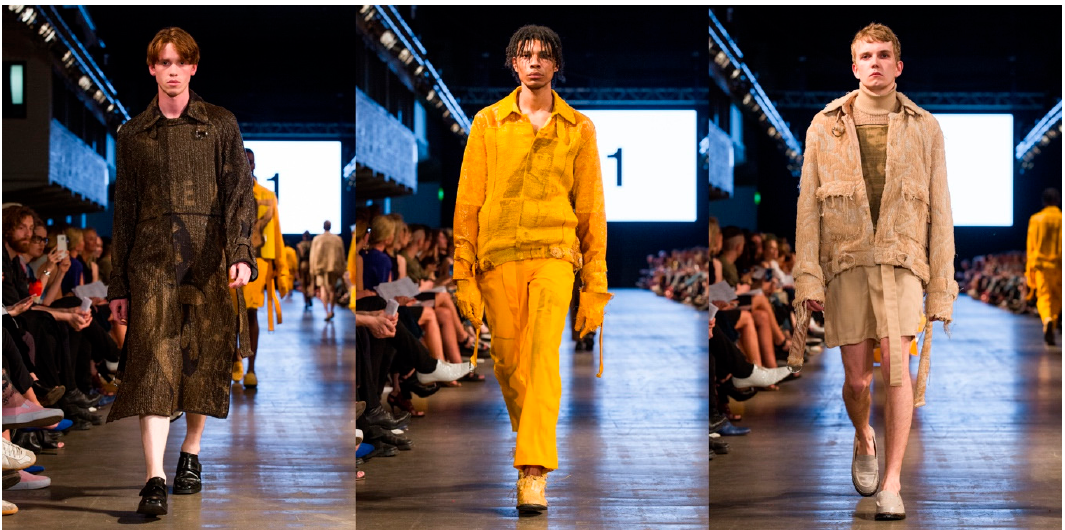
Figure 4. Maria Korkeila, BA Collection 2016, Aalto ARTS Näytös16 fashion show, Finalist and